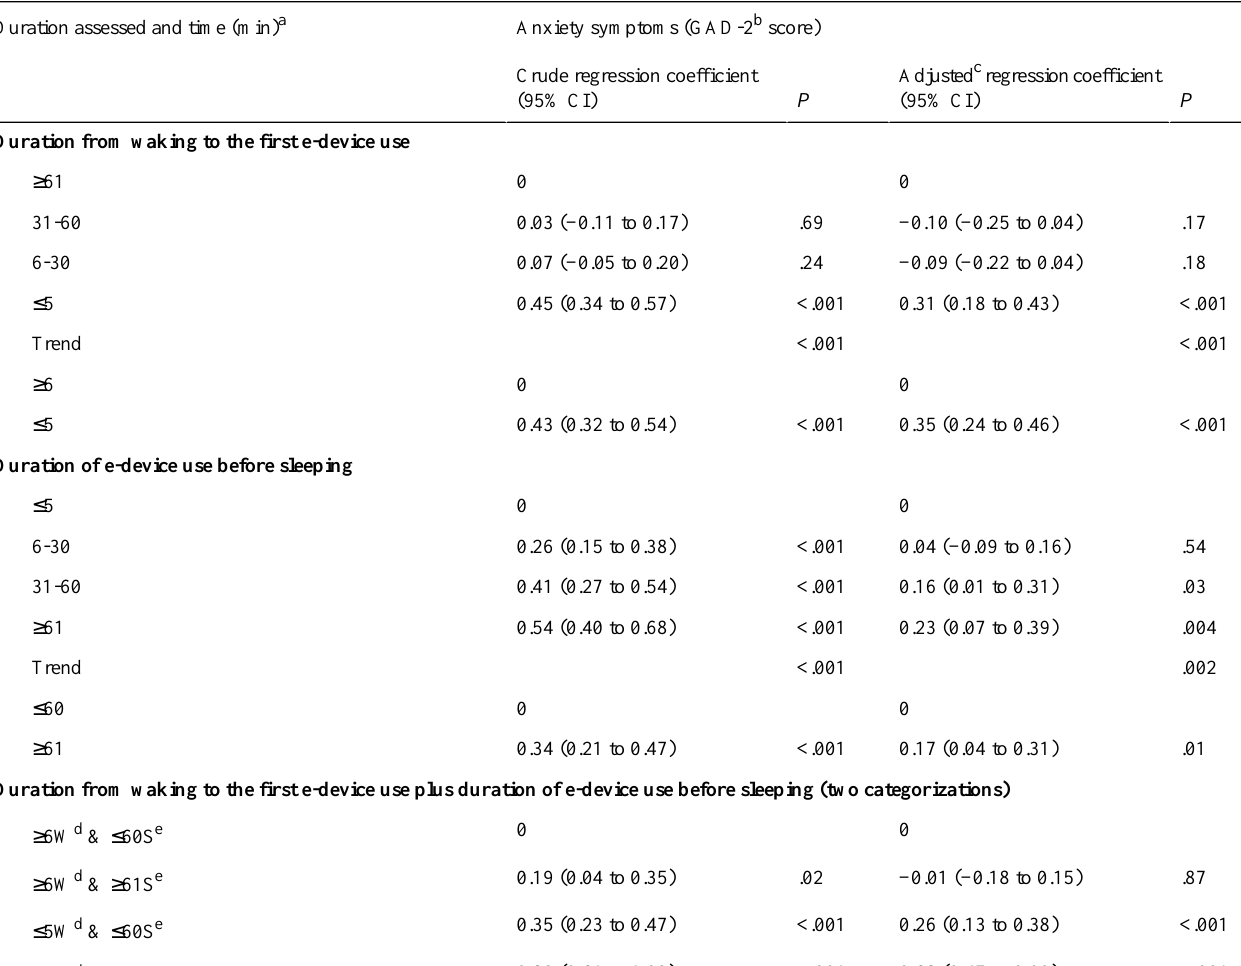
Table 2. Linear regression of anxiety symptoms for the duration from waking to the first e-device use and duration of e-device use before